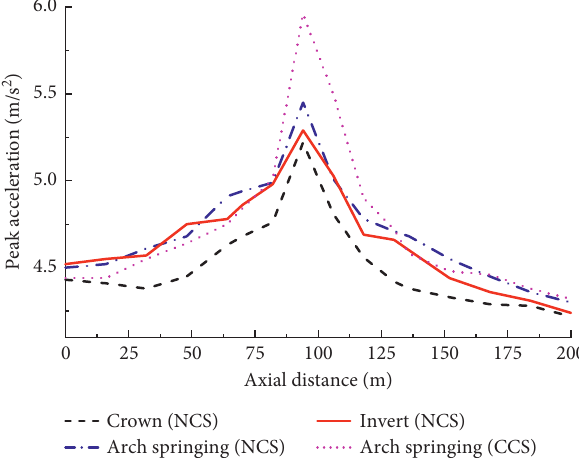
Figure 7: Changes in the peak acceleration of the composite structure along the length of the tunnel.